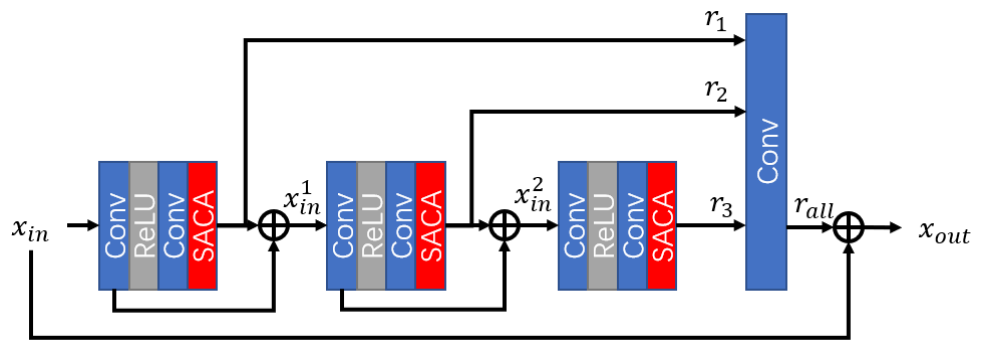
Figure 3. Block design of